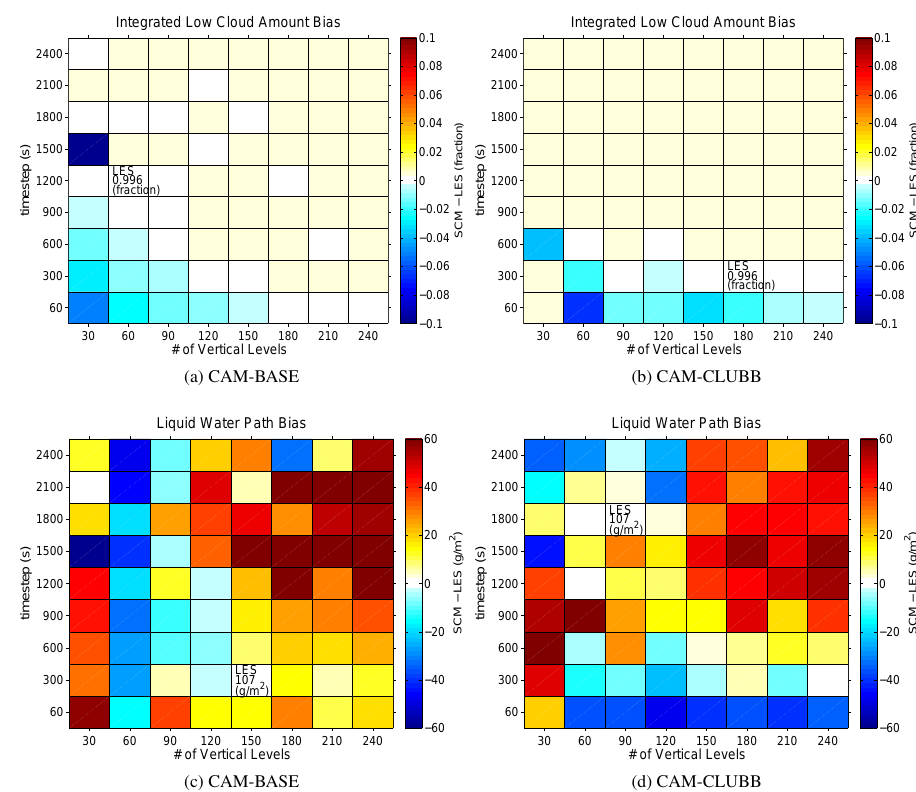
Fig. 11: Same as Fig. 1 except averaged over hours 4–6 of the simulation for the DYCOMS2-RF02 case of maritime stratocumulus.